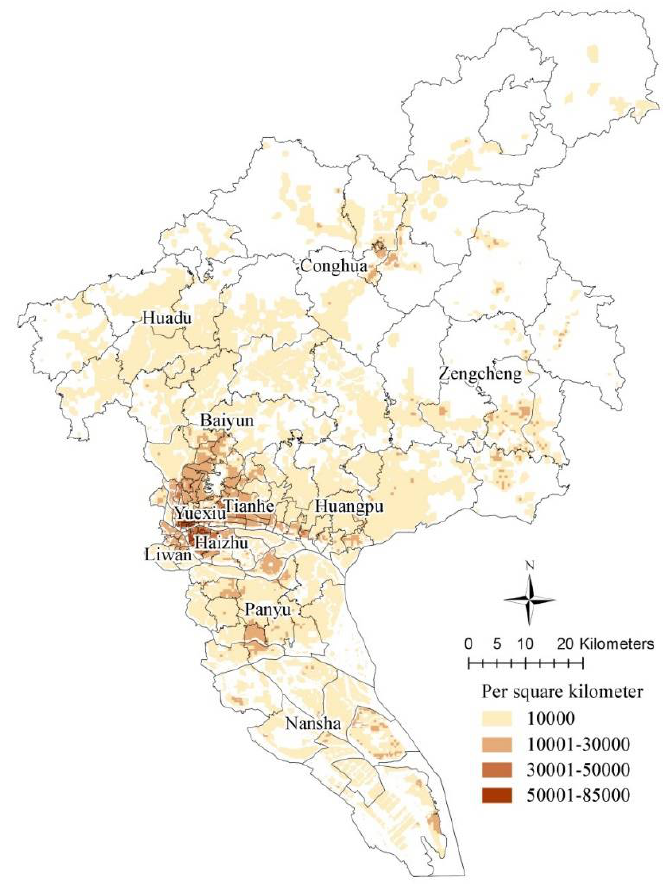
Figure 2. Planning community population density by 2020 (Source: Guangzhou City Master Plan for 2011–2020).